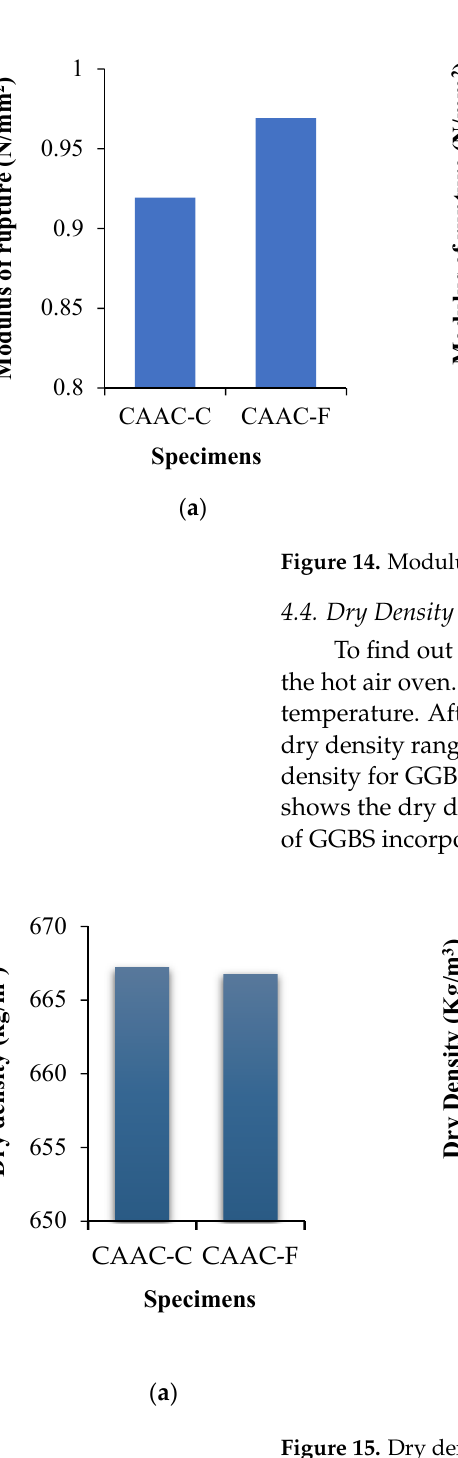
Figure 15. Dry density of ( a ) Conventional AAC and ( b ) GGBS incorporated in AAC.